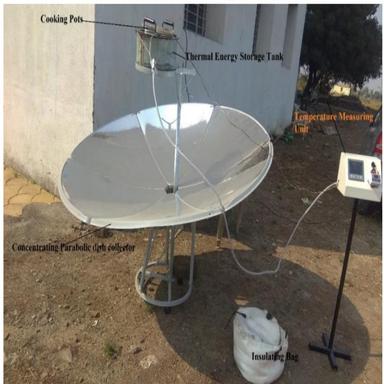
Experimental Set-up.